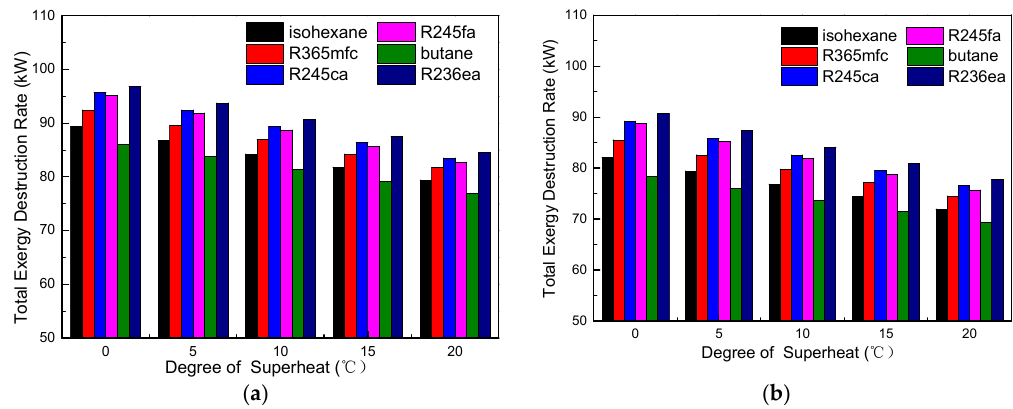
Figure 9. Comparisons of total exergy destruction rate for different working fluids at two evaporation